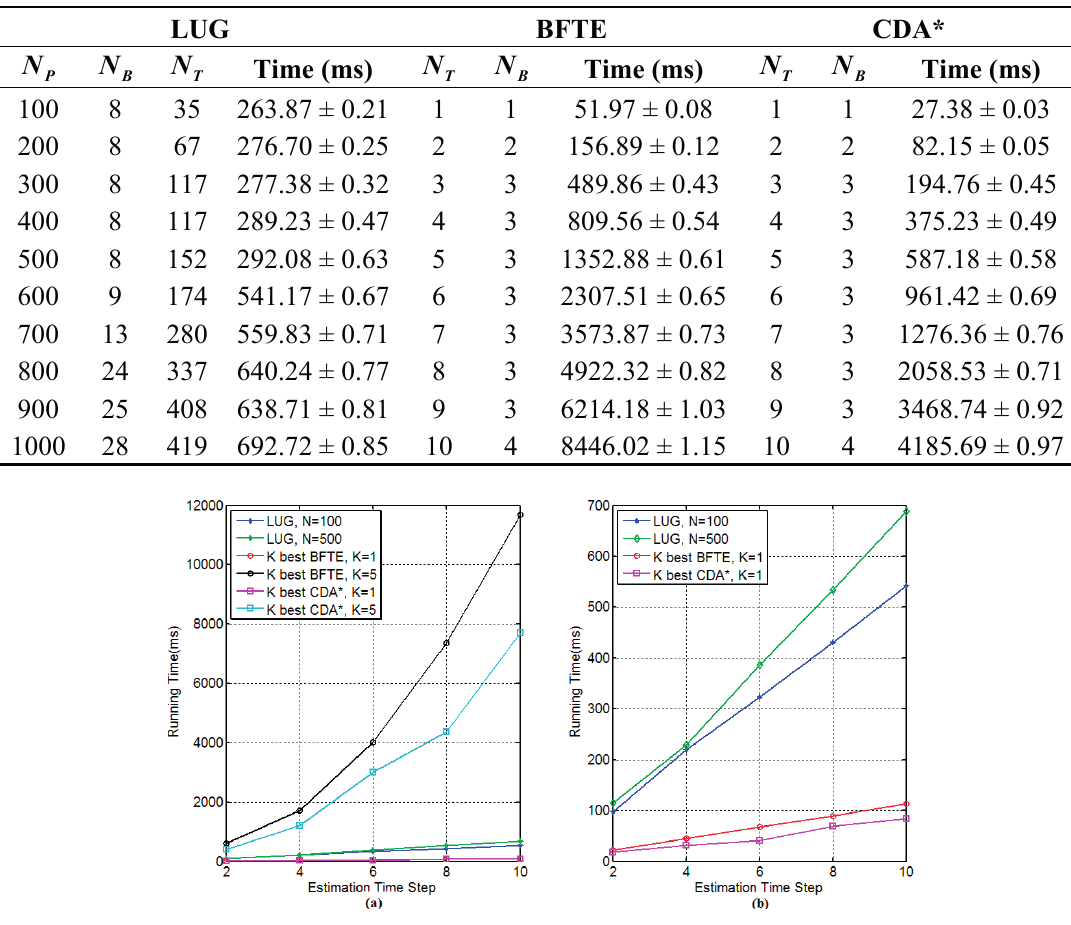
Table 6. The time consumption of different algorithms (confidence 95%).